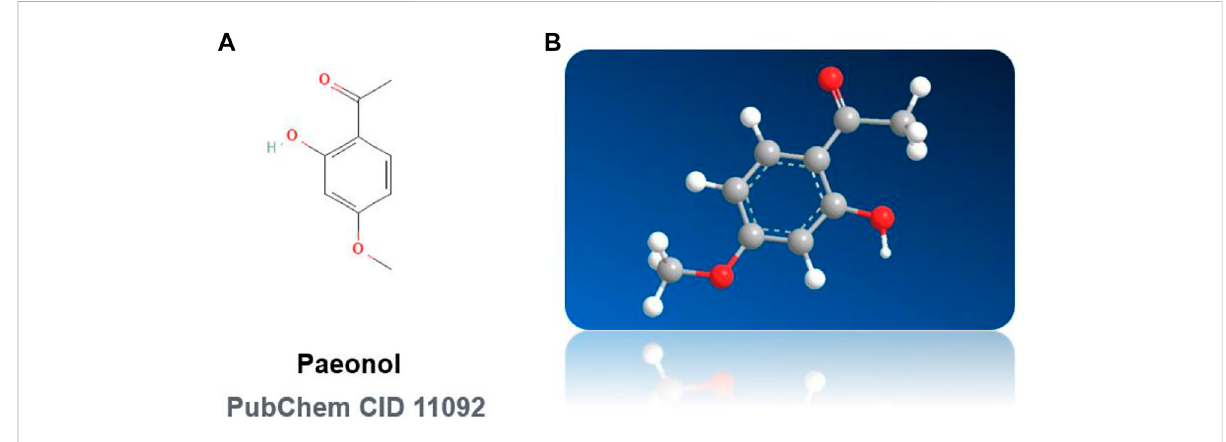
FIGURE 2 Chemical structures of paeonol. (A) Paeonol: 2D Chemical Structural Formula. (B) Paeonol: 3D Chemical Structural Formula NOTE: (Pubchem CID